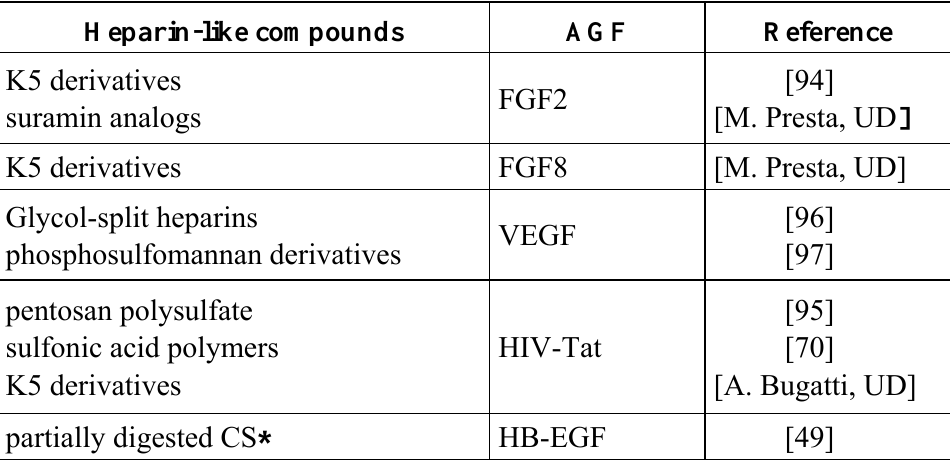
Table 5. Polyanionic heparin-like compounds investigated by SPR for their capacity to inhibit the binding of AGFs to heparin immobilized to the